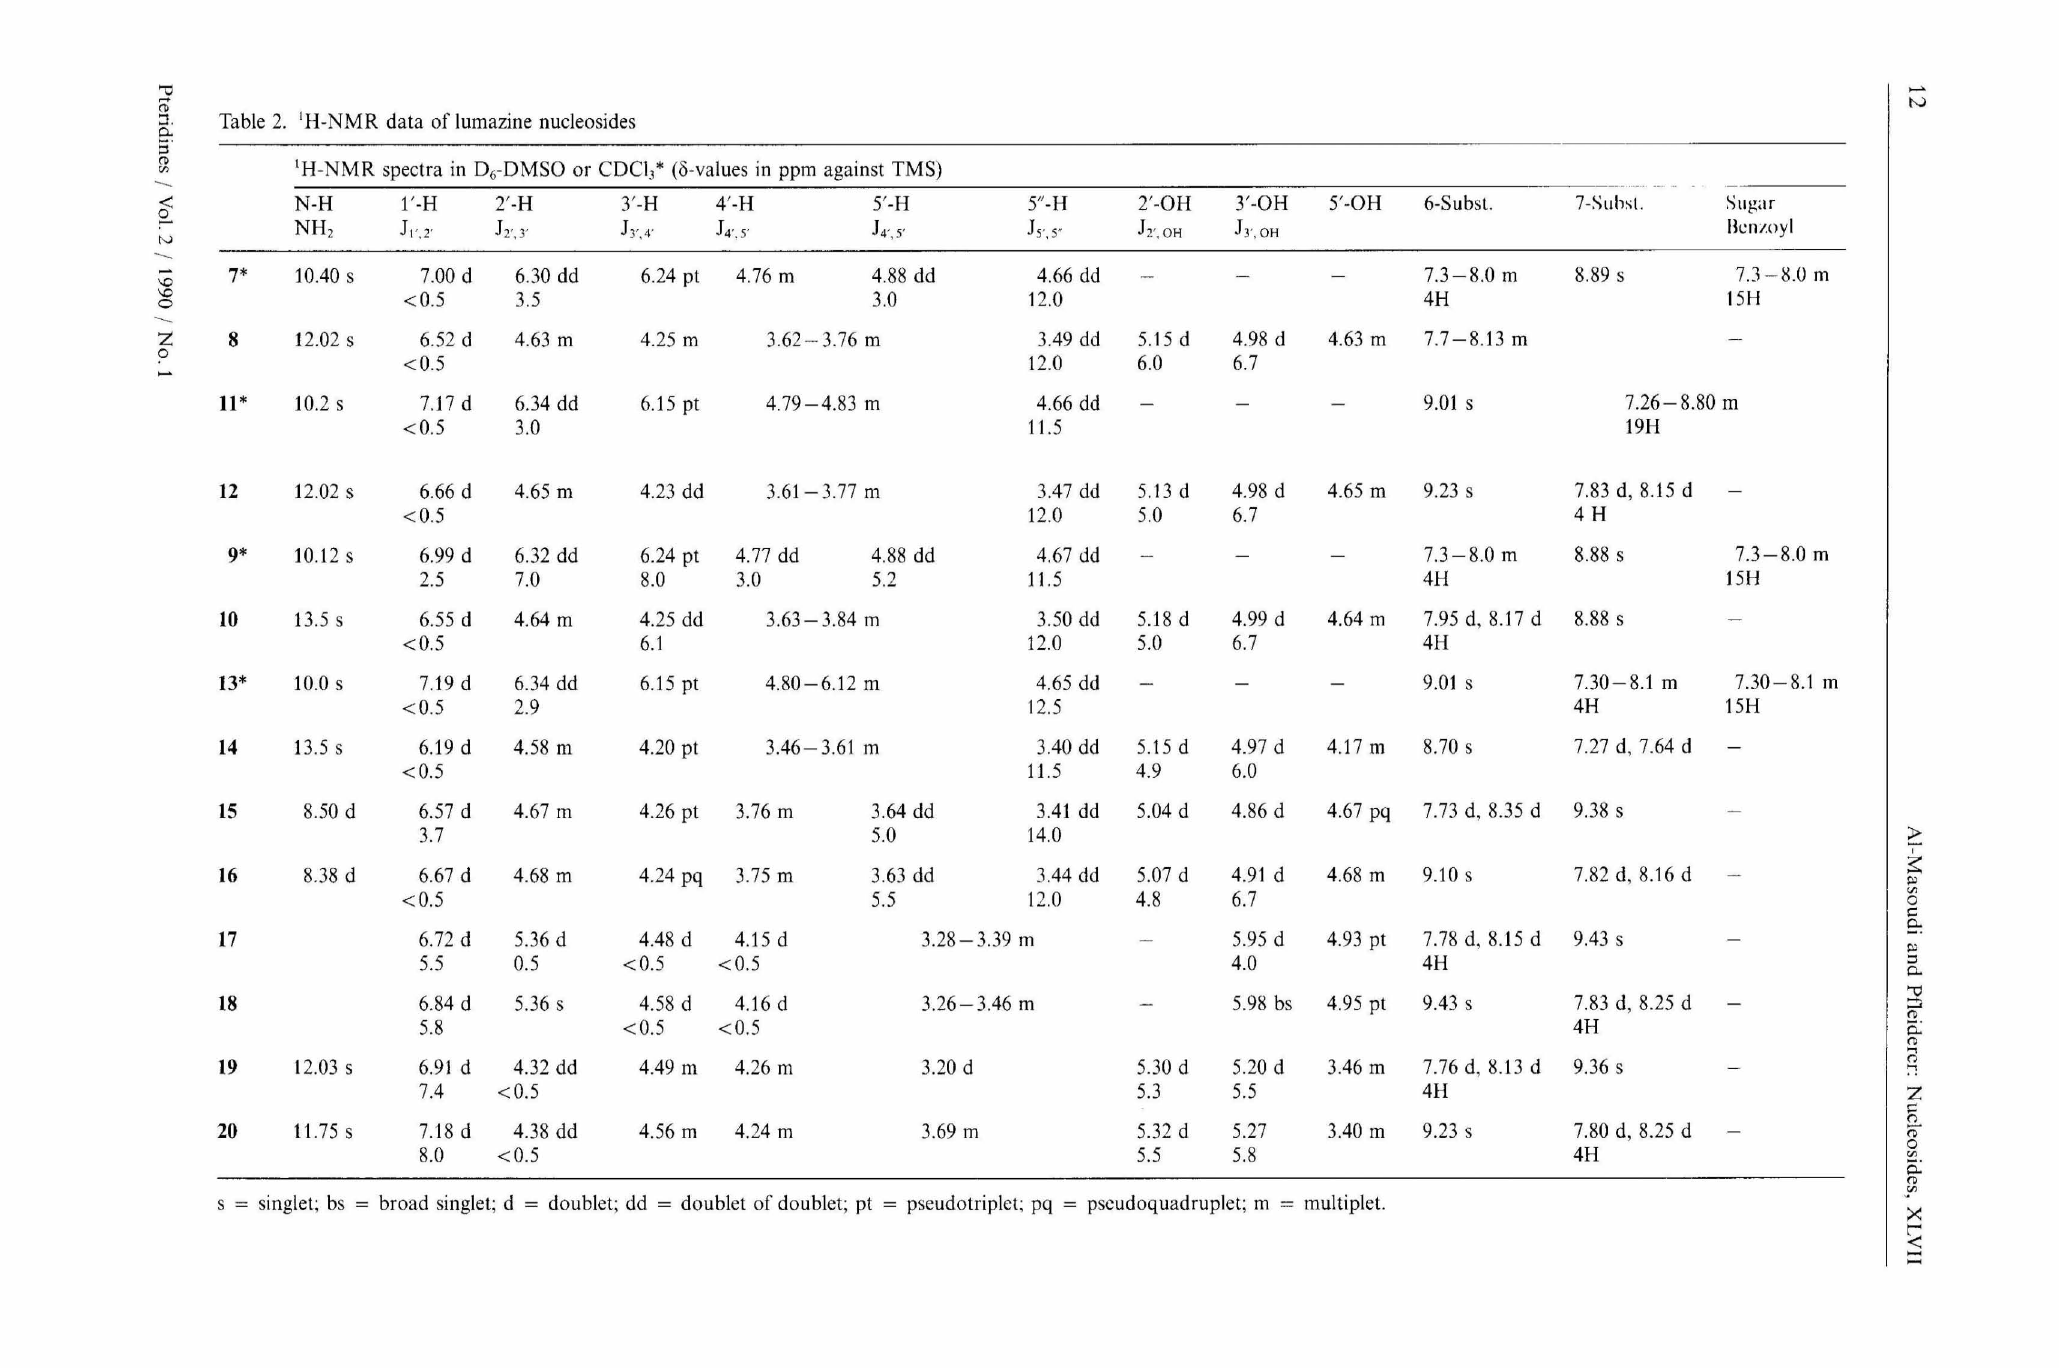
Table 2. lH-NMR data of lumazine nucleosides P- O·